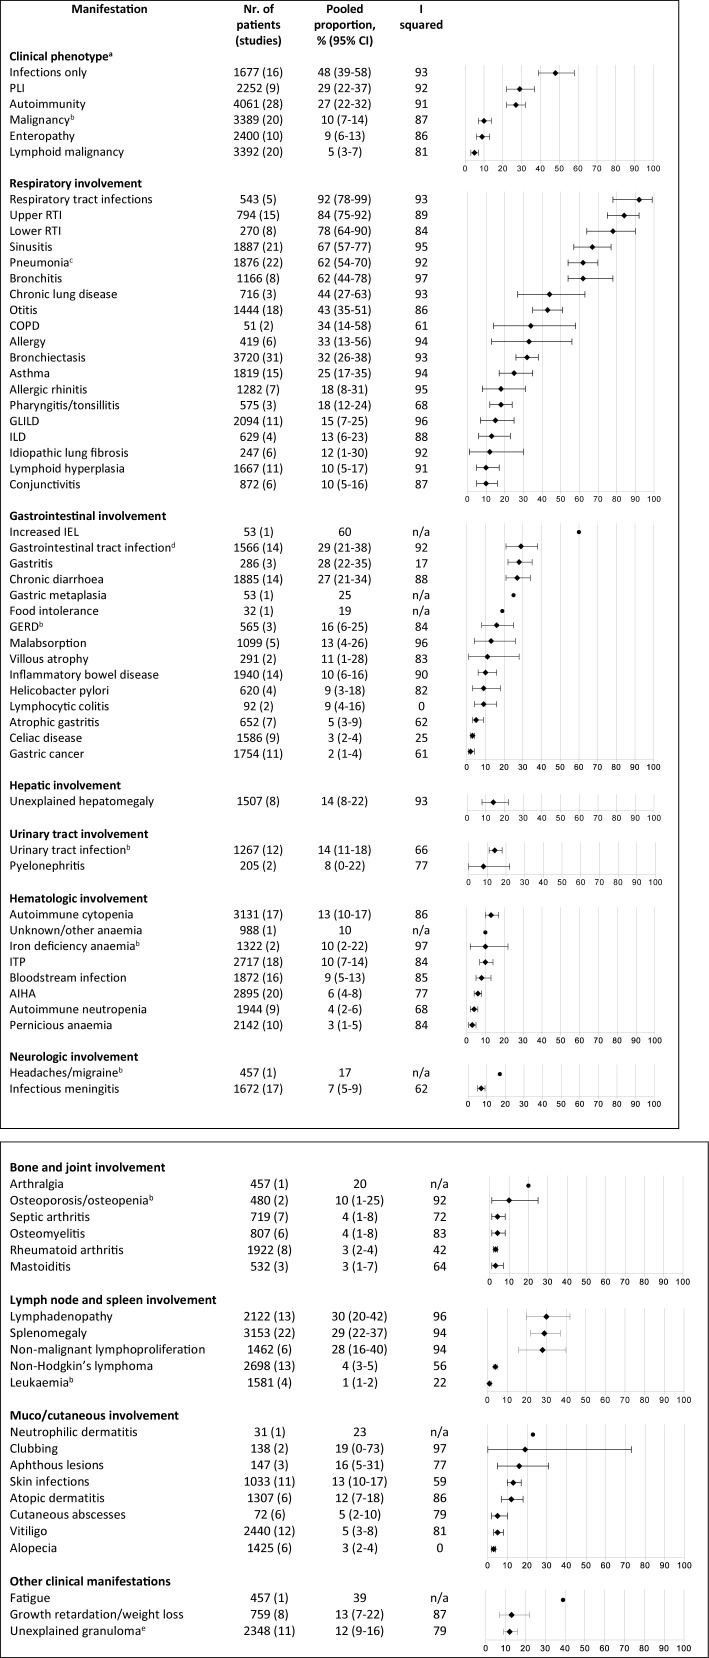
Frequency of reported clinical manifestations of patients with common variable immunodeficiency. All clinical manifestations that were present in ≥10% of patients are shown; the CVID-associated manifestations are also shown when present in <10% when they were considered important to incorporate by the authors (based on current literature and consensus in the field). aDerived from Chapel et al. (26). bThe prevalence of this clinical manifestation is similar or lower to lifetime prevalence estimates in general population. cStreptococcus pneumoniae 15%, 95% CI 8-23; Hemophilus influenzae 19%, 95% CI 8-33; Moraxella catarrhalis 7%, 95% CI 0-19; Staphylococcus aureus 7%, 95% CI 3-12; Mycobacterial infection 1%, 95% CI 0-2; Pneumocystis jiroveci 1%, 95% CI 0-2%; Pseudomonas 6%, 95% CI 2-10; Aspergillus 3%, 95% CI 1-5; Mycoplasma 2%, 95% CI 0-4. dGiardia intestinalis 13%, 95% CI 7-21; Candida species 10%, 95% CI 4-19; Salmonella species 6%, 95% CI 2-12; Campylobacter species 4%, 95% CI 1-8.eIntestinal granulomatosis 1%, 95% CI 0-4; liver granuloma 3%, 95% CI 1-6; granuloma in lymph node 2%, 95% CI 0-5; granuloma in spleen 1%, 95% CI 0-2; skin granuloma 1%, 95% CI 0-2. AIHA, autoimmune hemolytic anemia; COPD, chronic obstructive pulmonary disease; CVID, common variable immunodeficiency disorders; GERD, gastro-esophageal reflux disease; GLILD, granulomatous and lymphocytic interstitial lung disease; IEL, increased intraepithelial lymphocytes; ILD, interstitial lung disease; ITP, idiopathic thrombocytopenic purpura; PLI, polyclonal lymphocytic infiltration; RTI, respiratory tract infection.